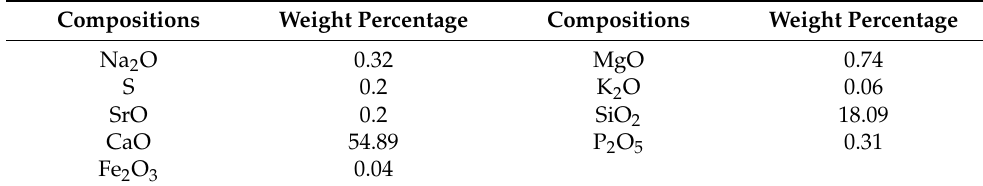
Table 2. The chemical analysis of eggshell powder using the XRF method.